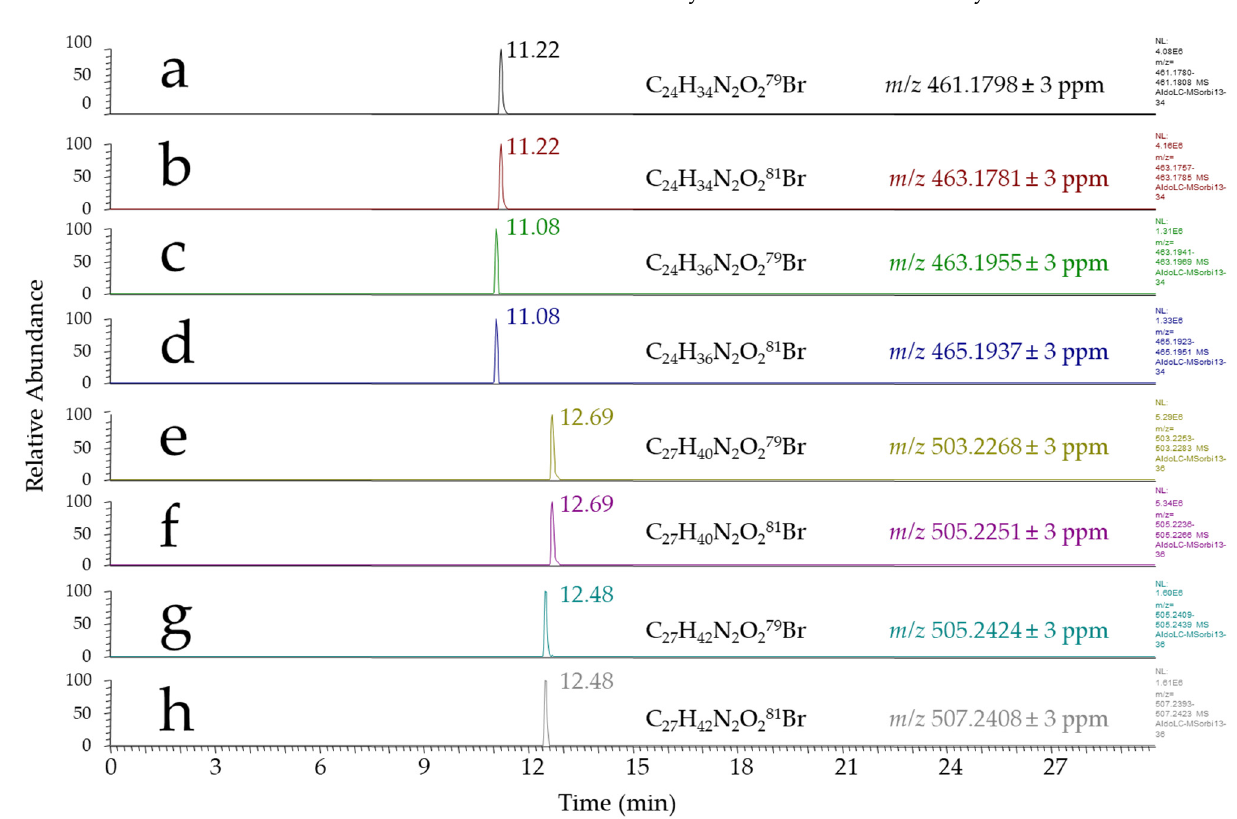
Figure 2. LC–HRMS-extracted chromatograms: ( a , b ) ion chromatograms of the 79 Br and 81 Br isotopomers of HHE-APEBA; ( e , f ) ion chromatograms of the 79 Br and 81 Br isotopomers of HNE-APEBA; and ( c , d , g , h ) ion chromatograms of their corresponding reduction byproducts.